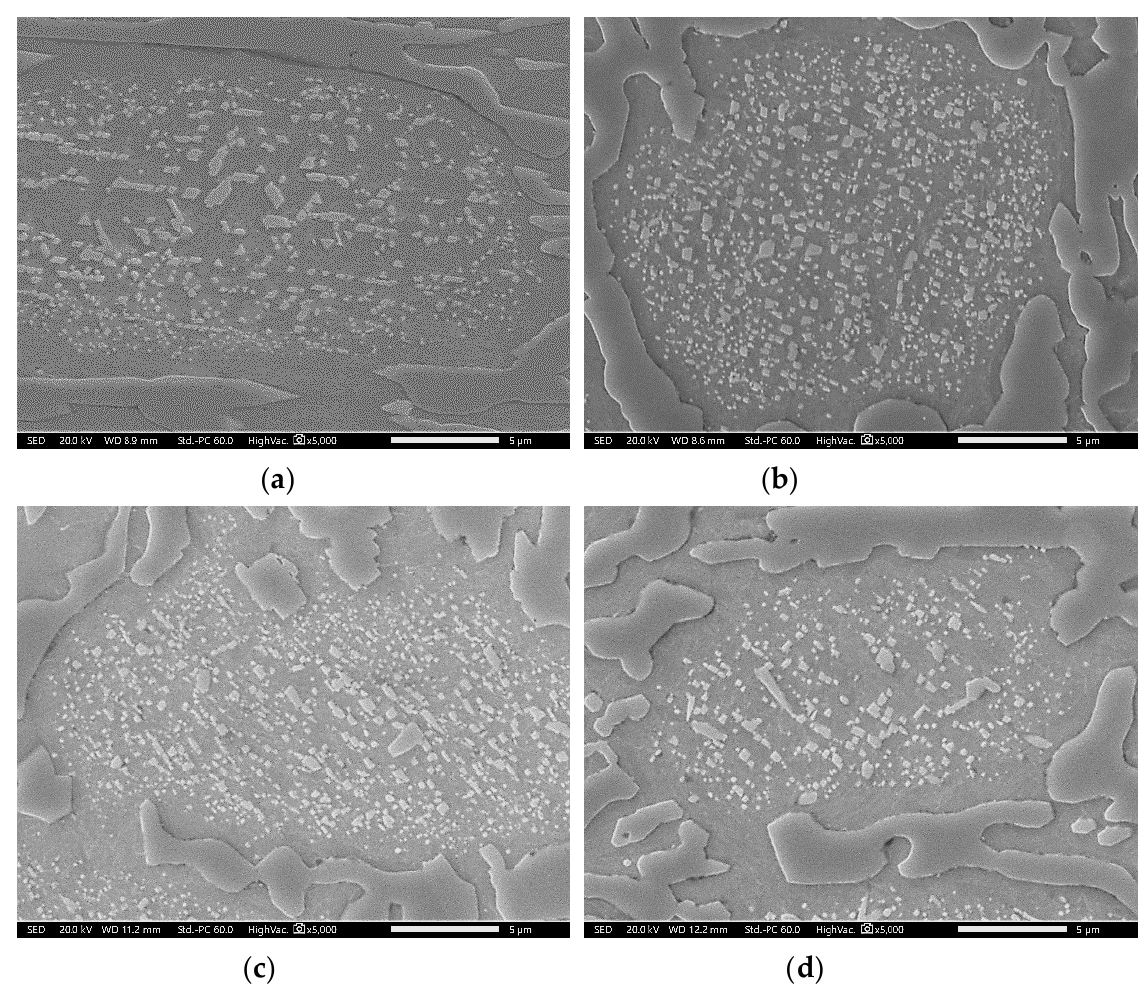
Figure 6. SEM micrographs in dendrite area of the conventionally heat-treated alloys: ( a ) 2124; ( b ) 2127; ( c ) 2427; ( d ) 2827; the 2927 alloy was excluded due to absence of dendrite.